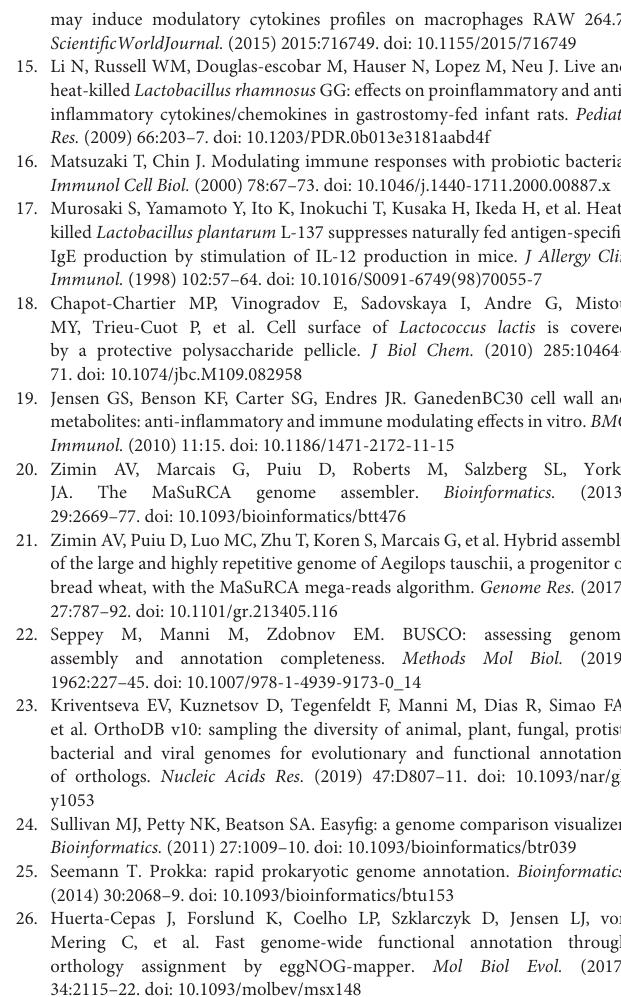
Supplementary Figure 9 | Pictorial description of heat-killed Lacticaseibacillus paracasei GMNL-653 exerts antiosteoporotic effects by restoring the gut microbiota dysbiosis in ovariectomized